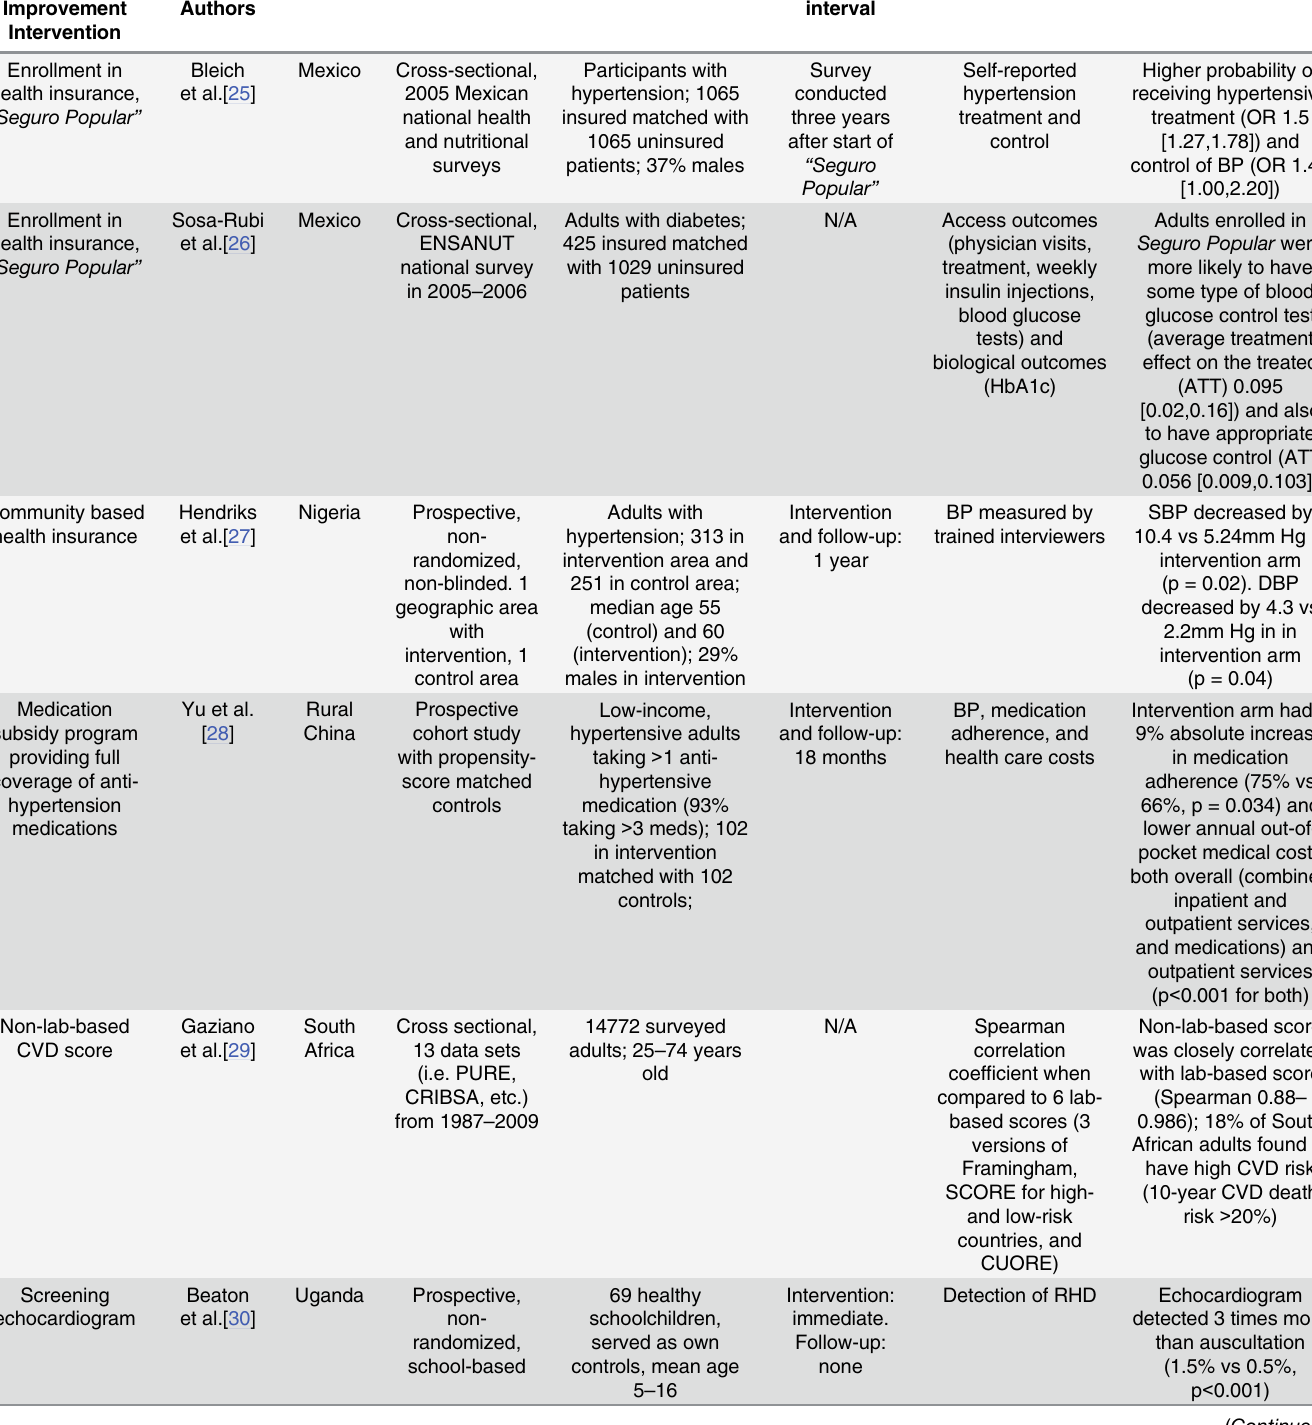
Table 3. System level-chronic phase CVD quality improvement studies identified during